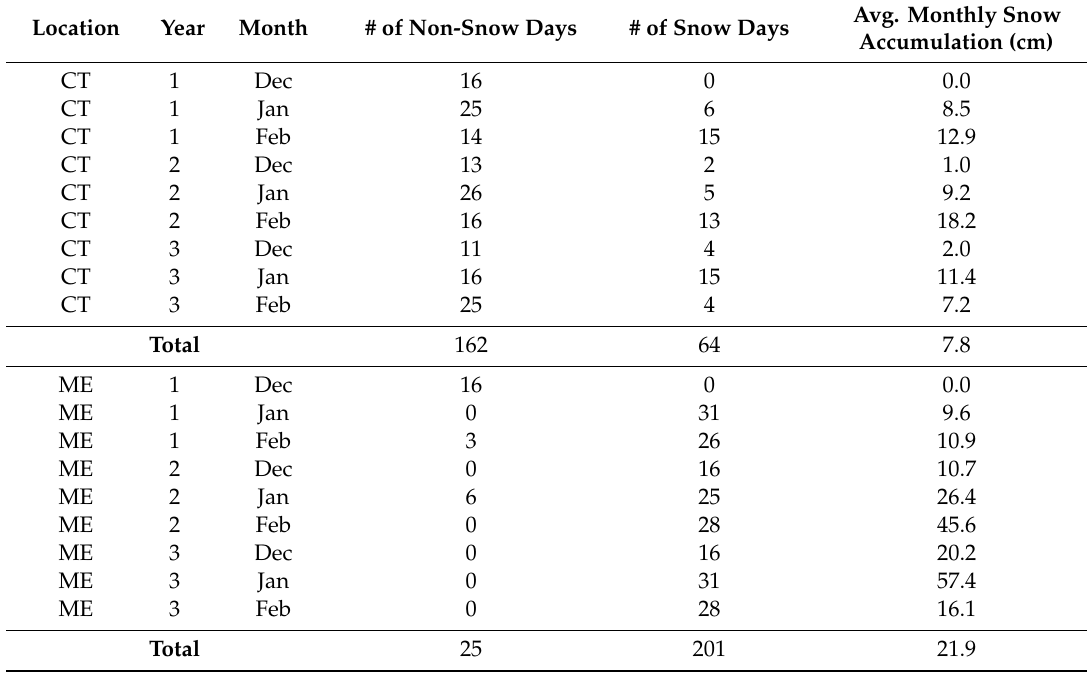
Table 4. Total number of non-snow days compared to days with snow for both Connecticut and Maine over the course of three winter seasons. For days with snow, average monthly snow accumulation and total average snow accumulation were also